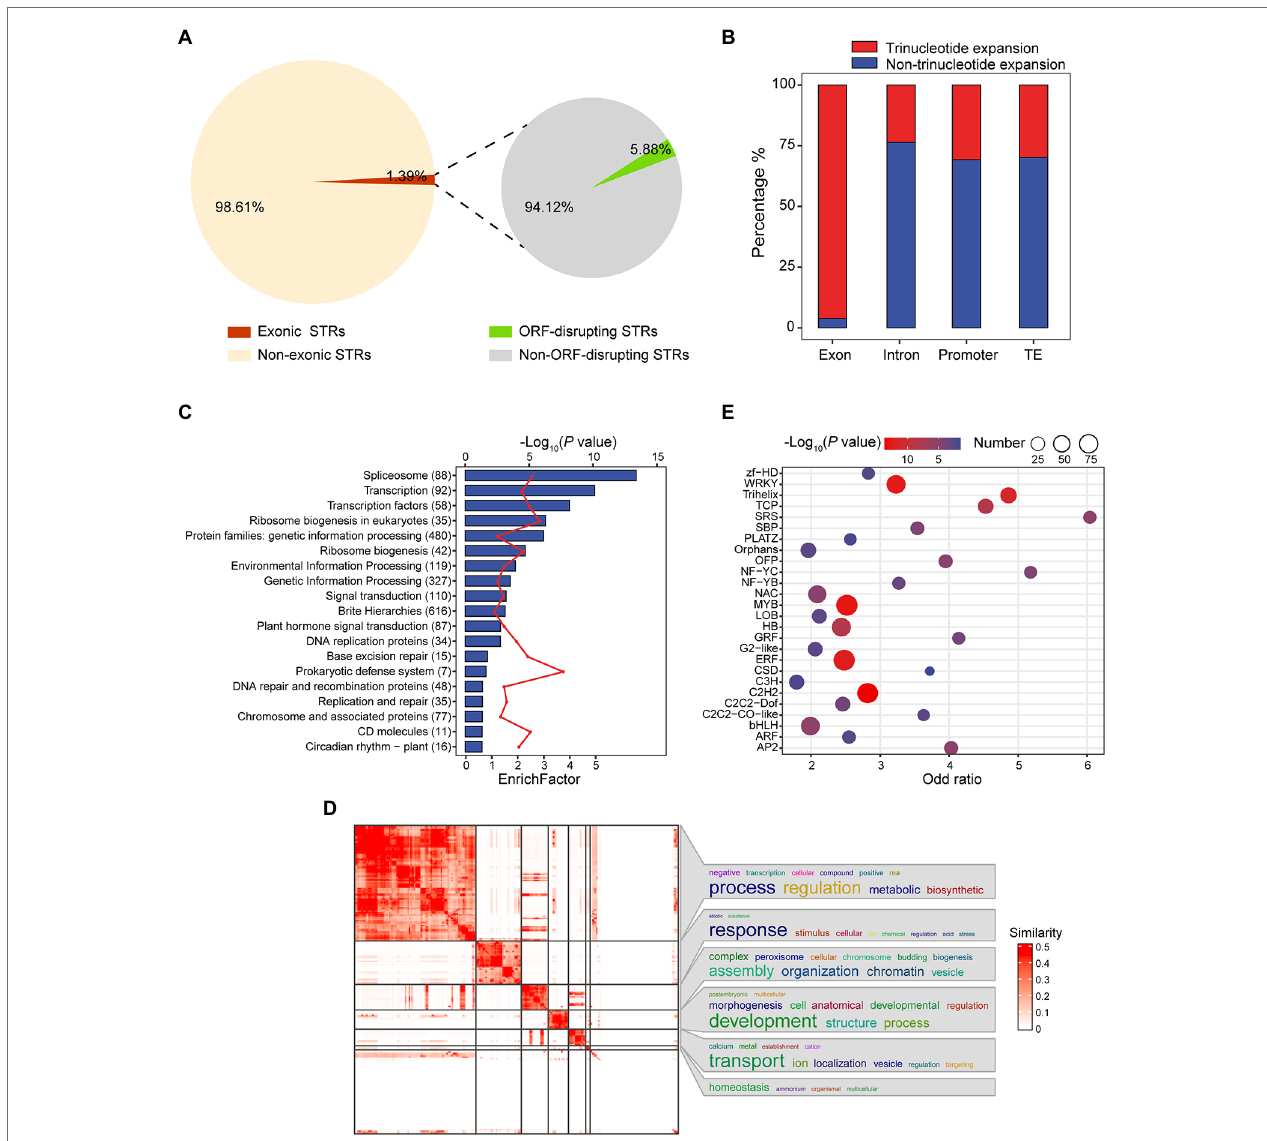
FIGURE 2 | Investigating the impacts of STRs on genes. (A) Pie charts showing the proportion of exonic STRs and the distribution of exonic STRs causing frameshifts. (B) Proportion of length variation at each STR locus across different genomic annotation sets, where length variation was computed as |Ref(STR length) − Alt(STR length)|. (C) Bar diagram showing the KEGG analysis of 6,021 genes with exonic STRs. Blue bars represent − log 10 ( p ), for which a greater value indicates higher enrichment degree. The red line represents the enrichFactor. The y -axis plots KEGG terms; numbers represent the genes included in each term. FDR < 0.01 was set as the cutoff. (D) Heat map showing similarities of significant GO biological process terms (FDR < 0.01) among the 6,021 genes with exonic STRs. The word cloud in the right panel visualizes the summarized biological functions in each GO cluster. GO enrichment analysis was performed using Fisher’s exact test and terms were clustered by the R package simplifyEnrichment . The color bar indicates similarity of GO terms. (E) Bubble chart of TF enrichment. Bubble size is directly proportional to the number of transcription factors. The x -axis represents odds ratio, while the y -axis lists transcription